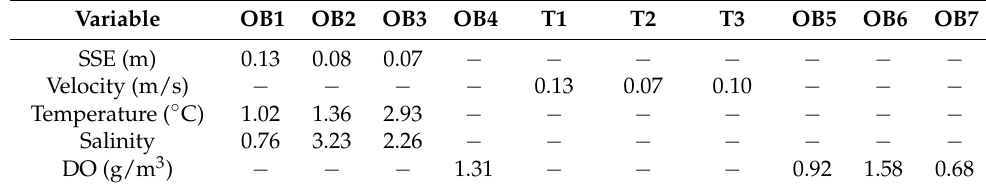
Table 4. RMSE for Ó bidos Lagoon (OB1, OB2, OB3, OB4, OB5, OB6, OB7, OB8)